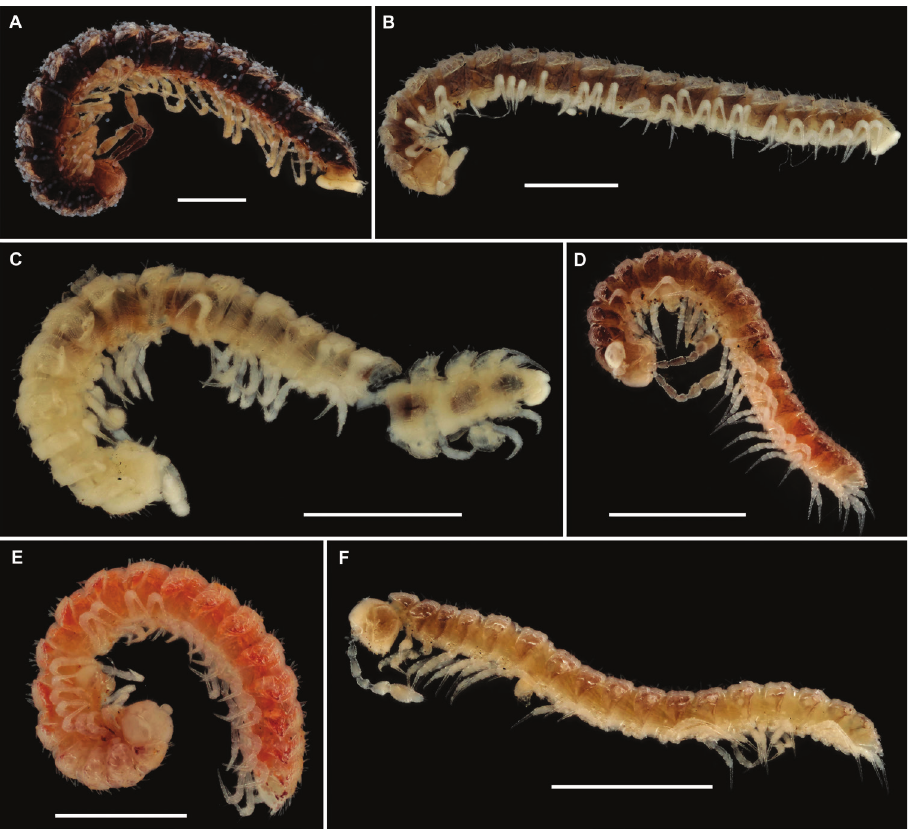
Figure 29. Habitus of Hemisphaeroparia species in lateral view, holotypes of H. fusca sp. n. ( A ), H. bonakan- da sp. n. ( B ), H. bamboutos sp. n. ( C ), H. subfalcata sp. n. ( D ), H. falcata sp. n. ( E ) and H. mouanko sp. n. ( F